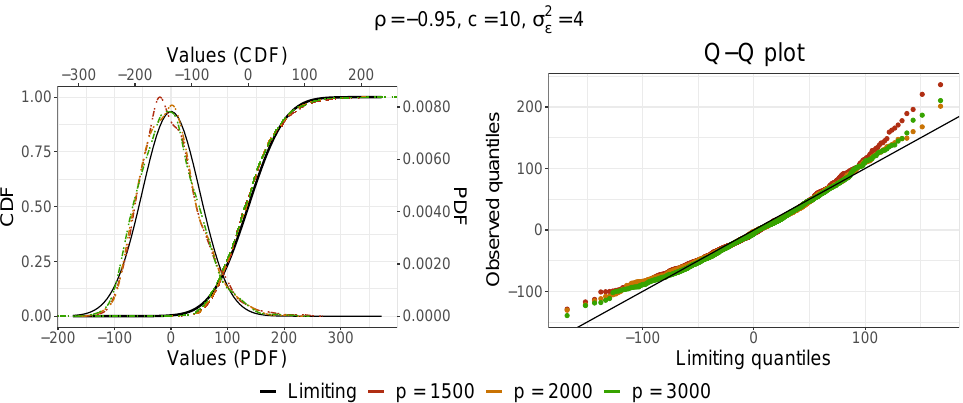
= 4 and p = 100,500,1000. ε